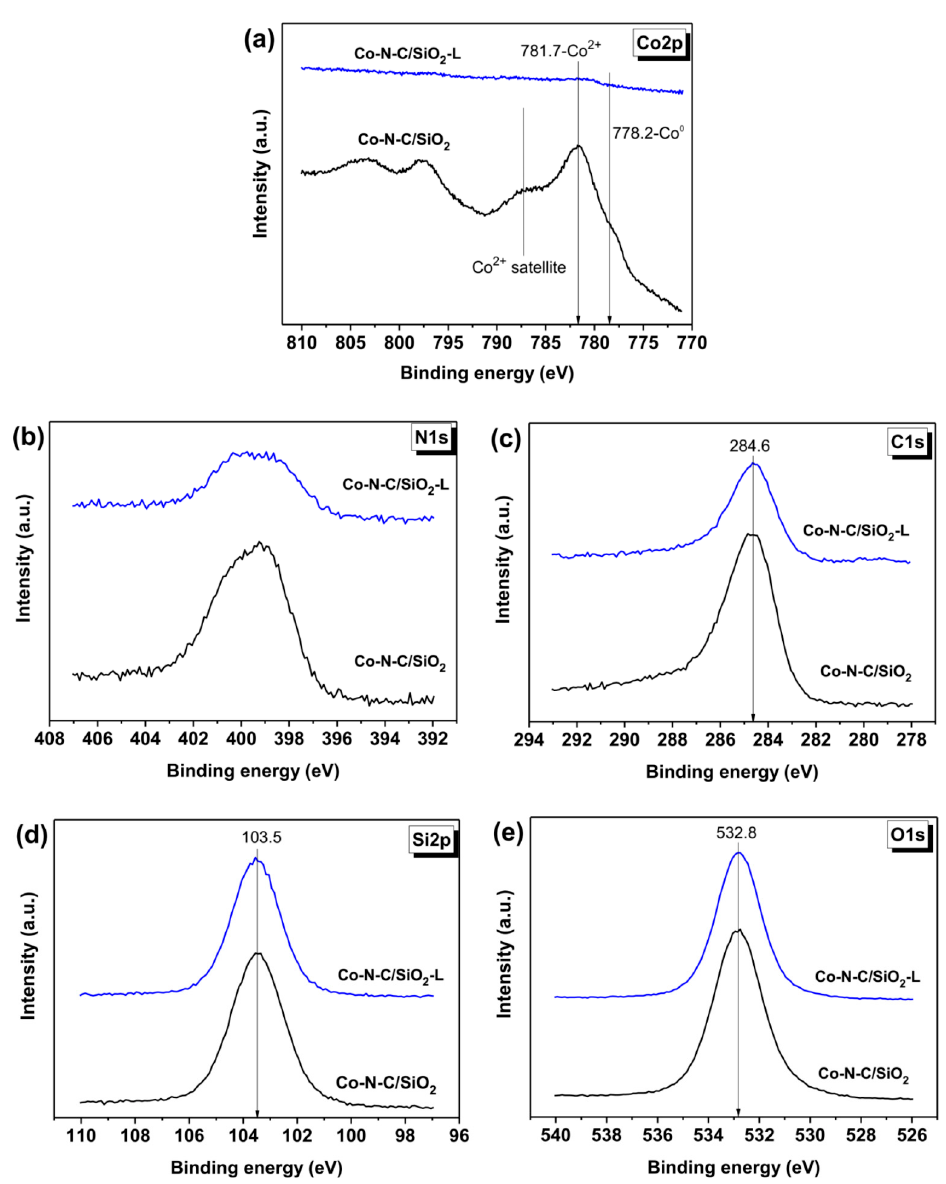
Figure 4. High resolution XPS spectra of ( a ) Co 2p, ( b ) N 1s, ( c ) C 1s, ( d ) Si 2p and ( e ) O 1s of the samples.